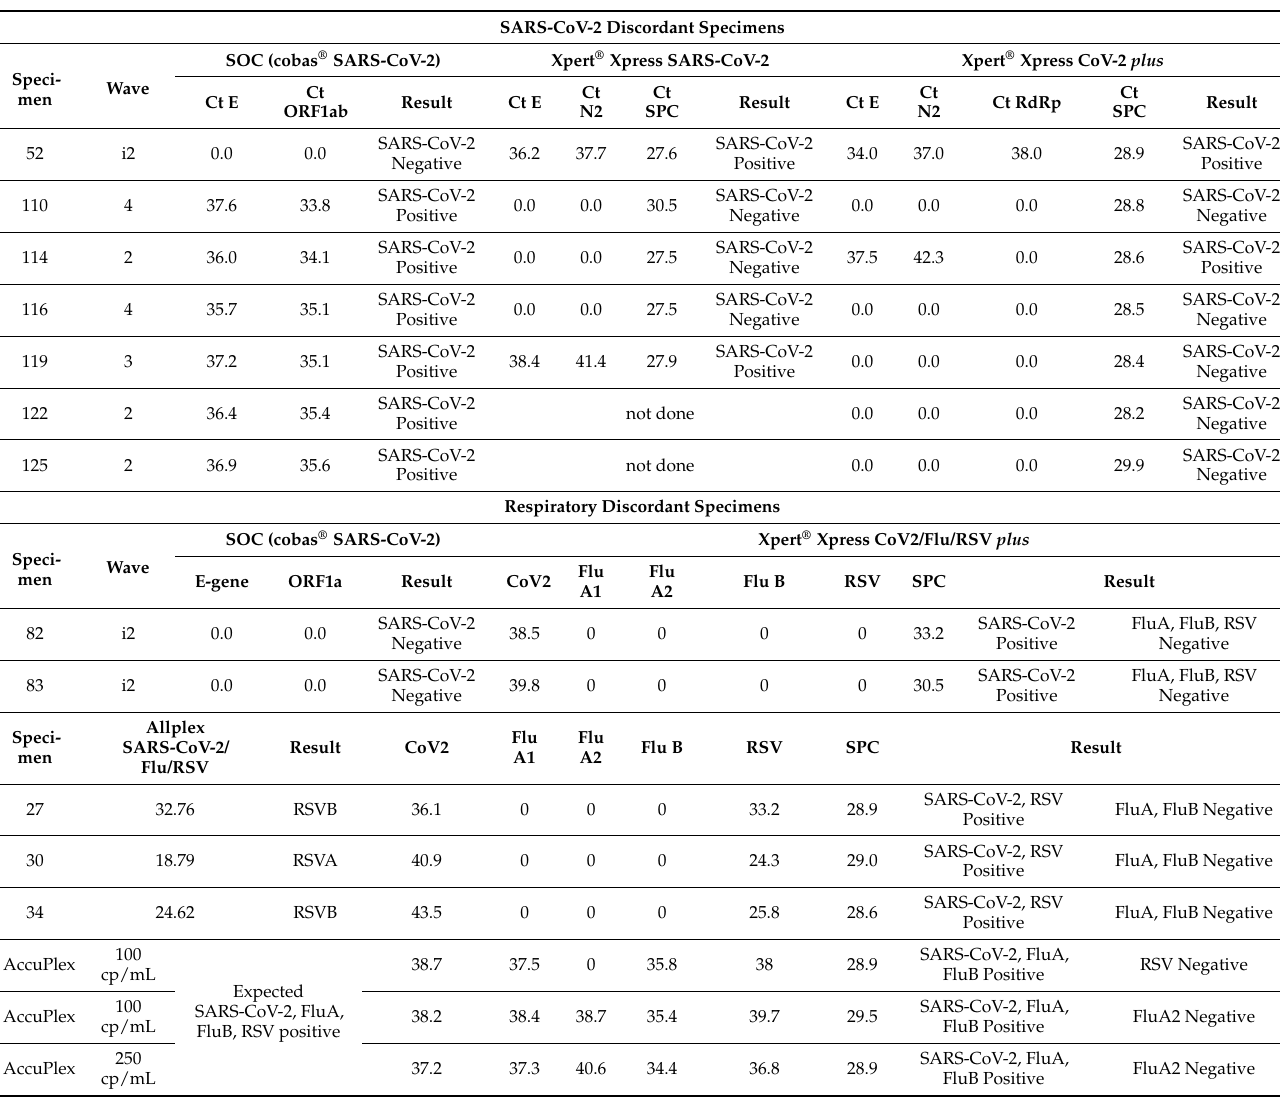
Table 2. Summary of discordant specimen results by Xpert ® Xpress SARS-CoV-2, Xpert ®